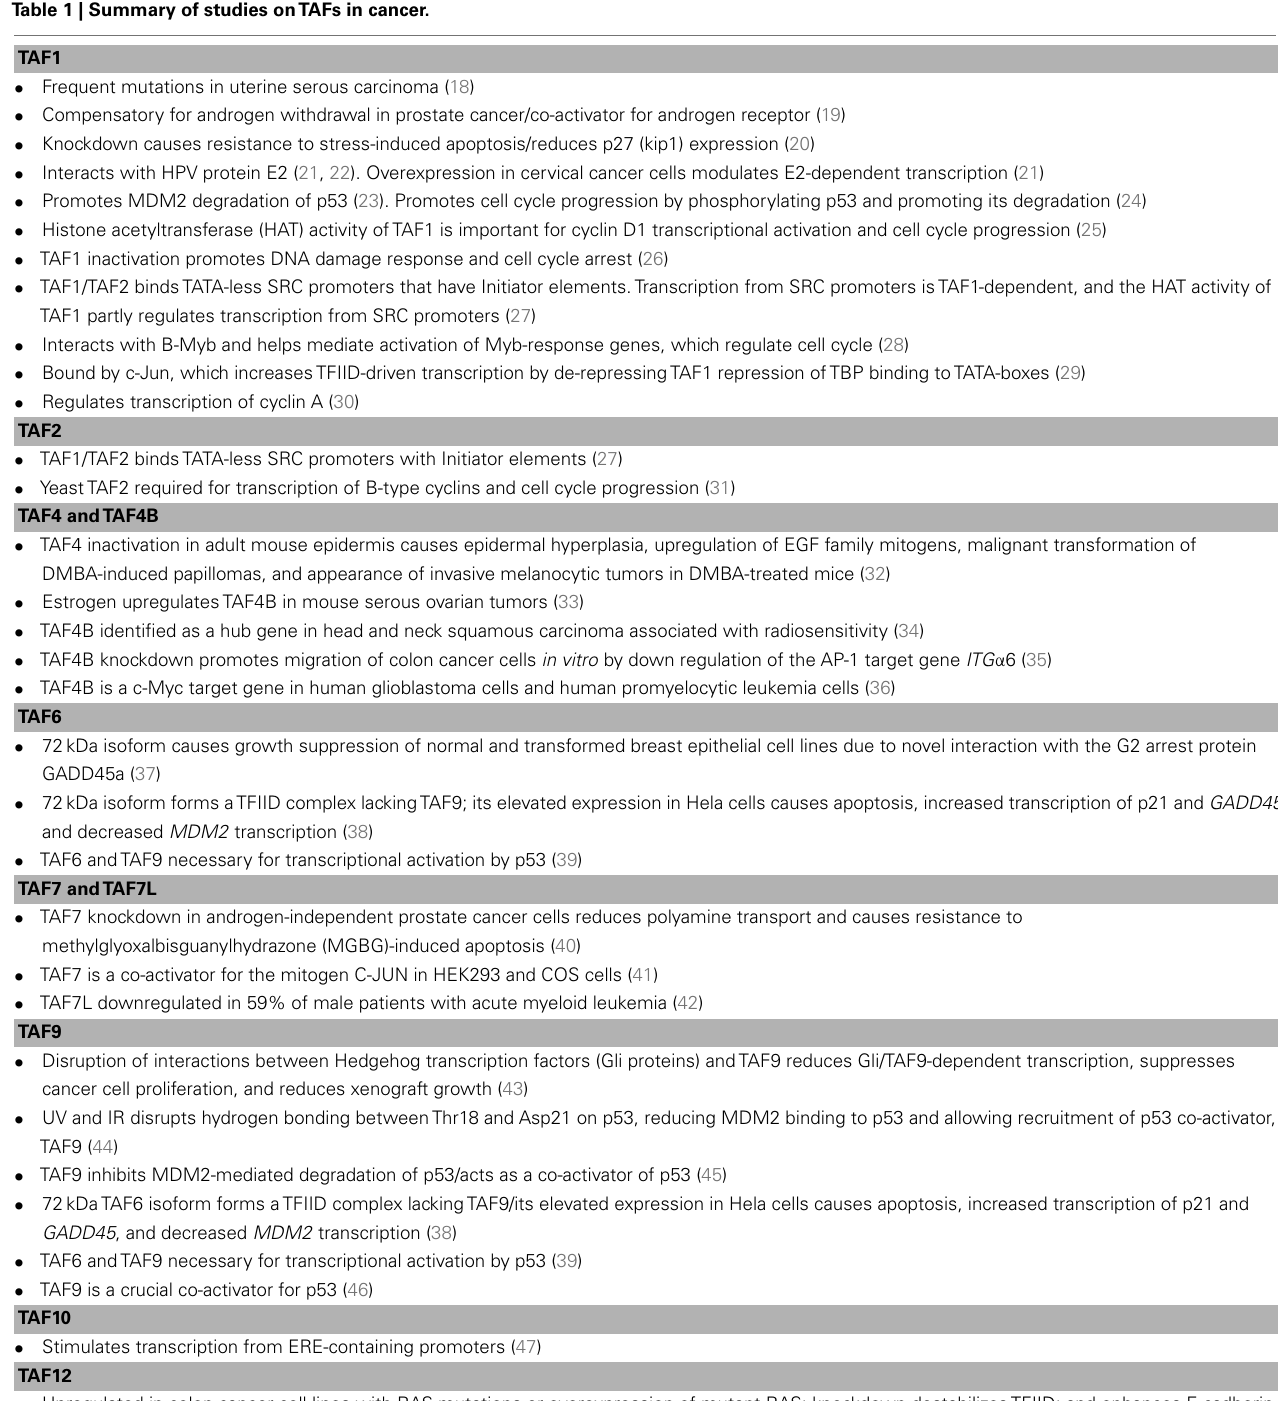
Table 1 | Summary of studies onTAFs in